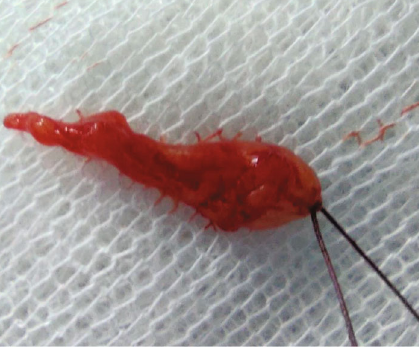
Figure 5: Resected